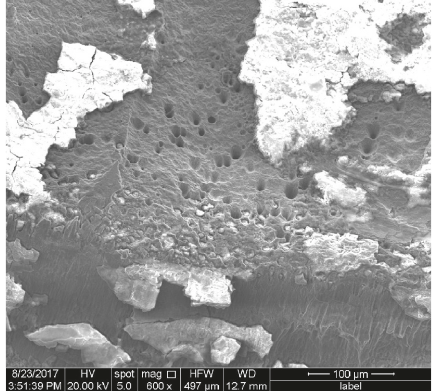
Figure 6: Micromorphology of fracture origin area.